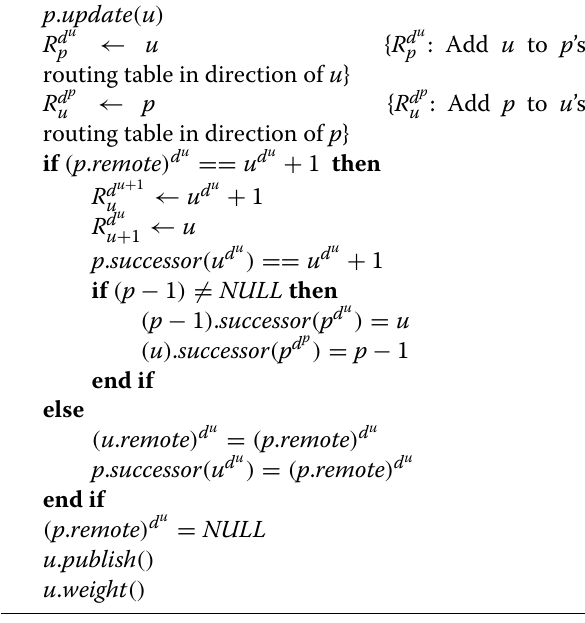
Algorithm 1 The update procedure between nodes p and